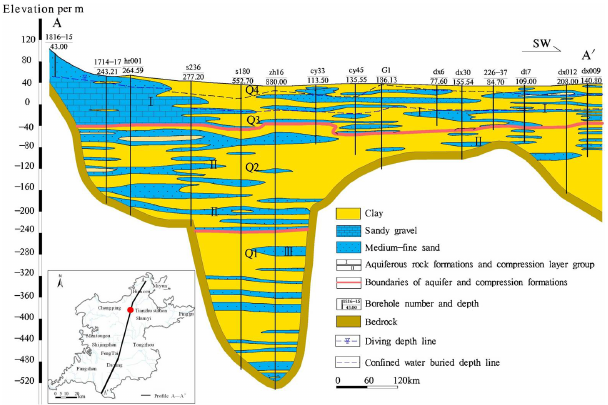
Figure 1. Hydrogeological cross-section A–A (cid:48) (the location is in- dicated in the lower left-hand